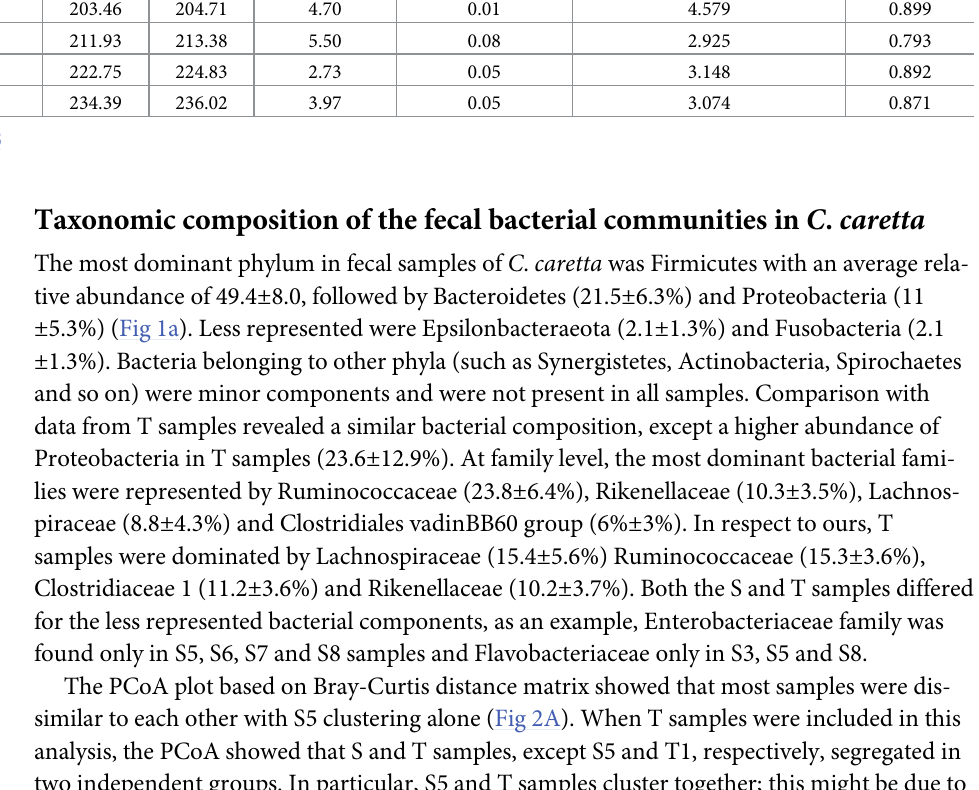
Table 3. Diversity indexes of the studied samples. Samples S are from this study, Samples T are from Abdelrhman et al . 23 . Sample